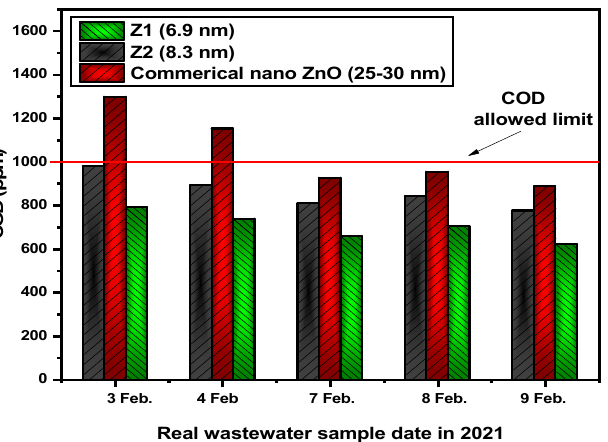
Figure 9. Evaluation of real industrial wastewater during photocatalysis by sunlight via the COD method.